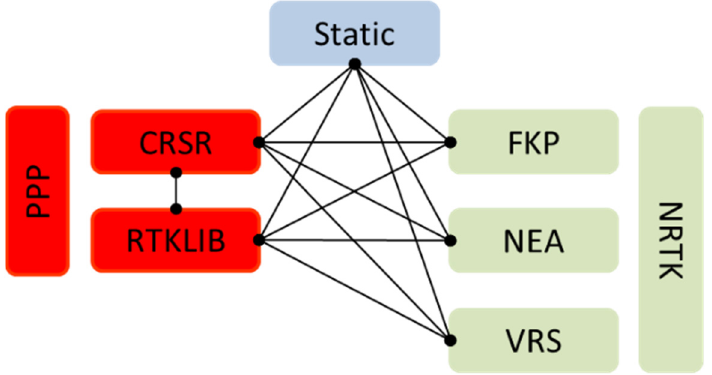
Figure 2. Conceptual scheme of comparisons. In light blue, green and red the 3 GNSS processing families: Static, NRTK and PPP, respectively. families: Static, NRTK and PPP,